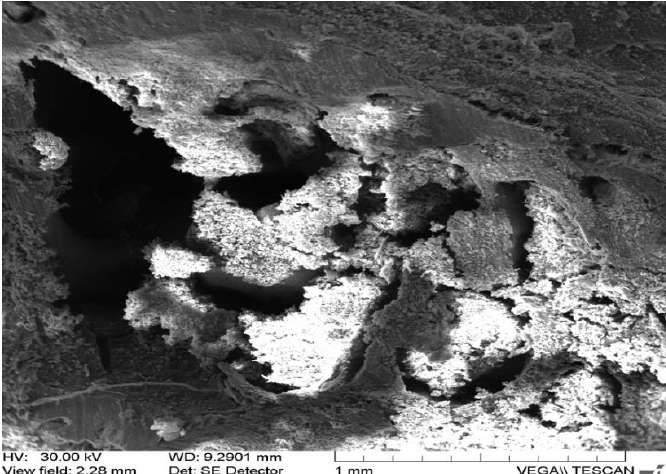
Figure 9. Detail of the previous image (Figure 8) in which the tendency of organization in steering paths in the vicinity of the fundamental external system of the bone is noticed (Bio Aggregate).